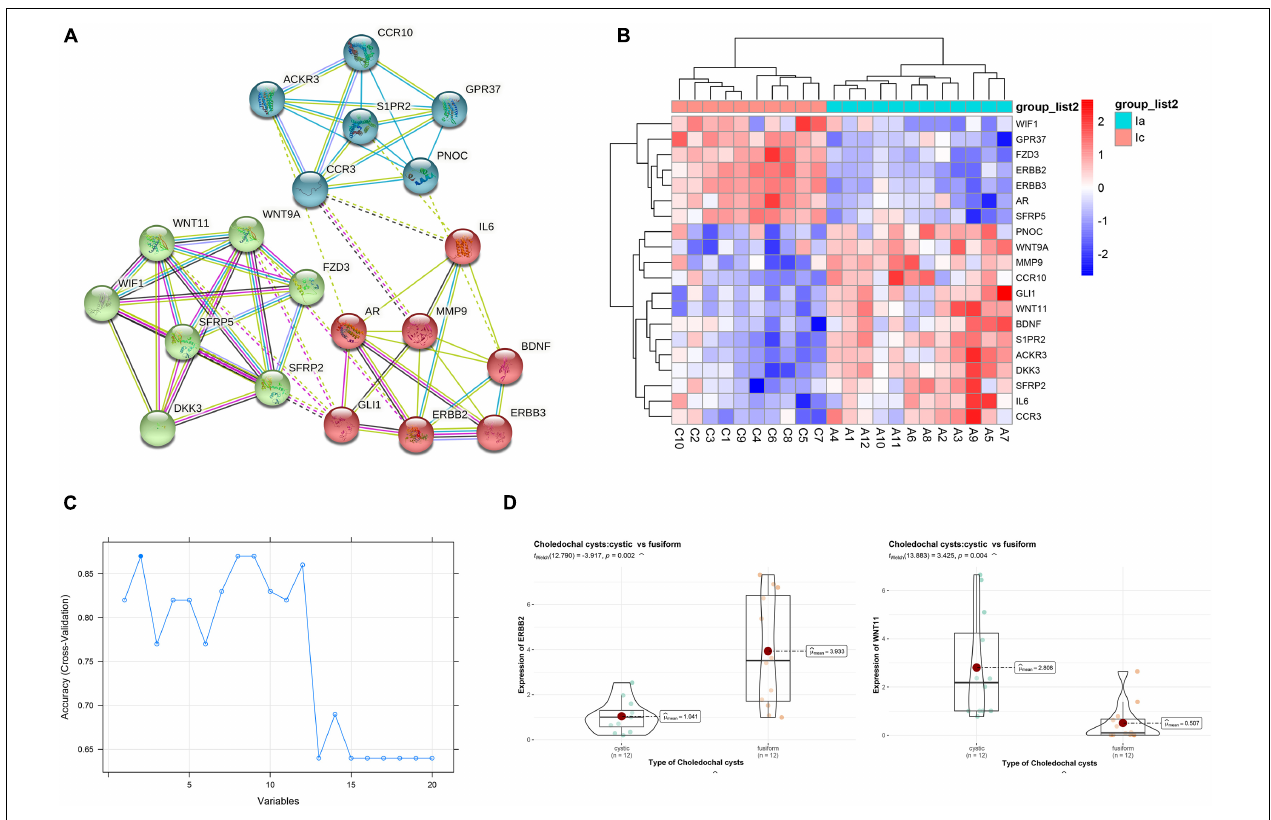
FIGURE 6 | Identification of hub genes. (A) The protein–protein interaction (PPI) network. (B) Heatmap of the 20 genes. (C) Support vector machine recursive feature elimination (SVM-RFE) algorithm to screen hub genes. (D) The violin plots of genes between cystic and fusiform CCs.